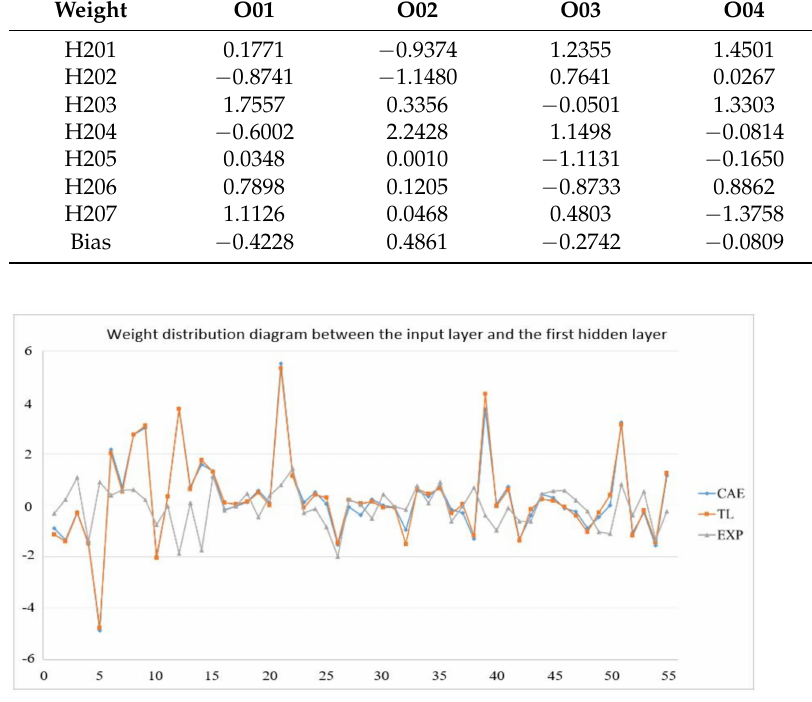
Figure 20. Weight distribution diagram between the input layer and the first hidden